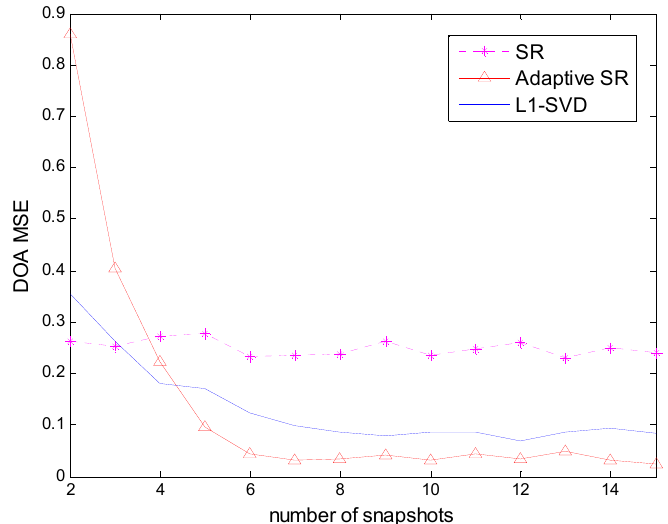
Figure 3. DOA MSE against the number of